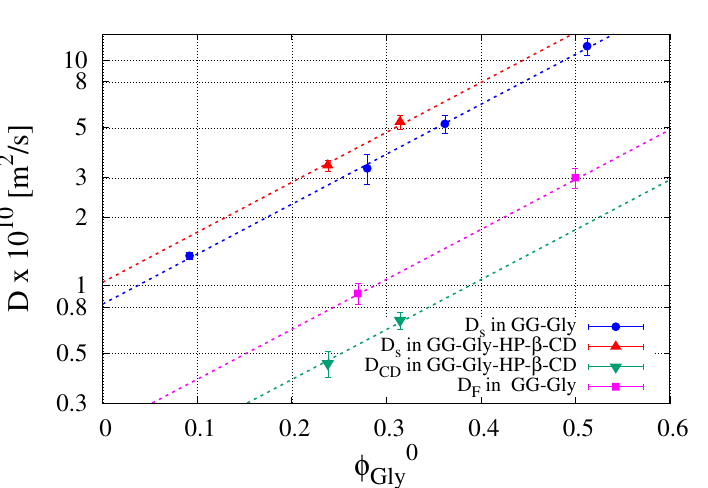
Figure 6. Log-normal plot of solvent diffusivity D s × 10 10 [m 2 /s], HP- β -CD diffusivity D CD × 10 10 [m 2 /s] and fluconazole diffusivity D F × 10 10 [m 2 /s] vs. glycerol volume fraction φ 0 Dashed lines represent the exponential behavior D ∼ exp ( 5.1 φ 0